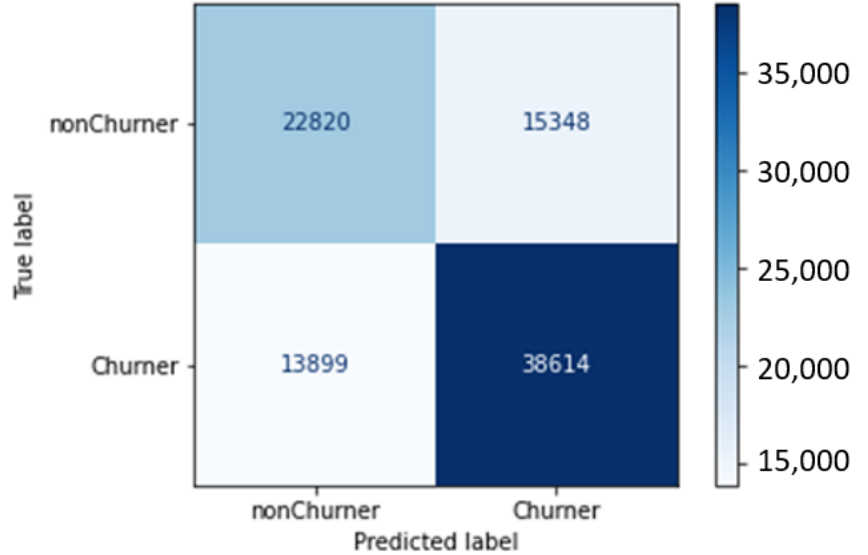
Figure 13. Confusion matrix—1 day of feature extraction and 1 day of churn